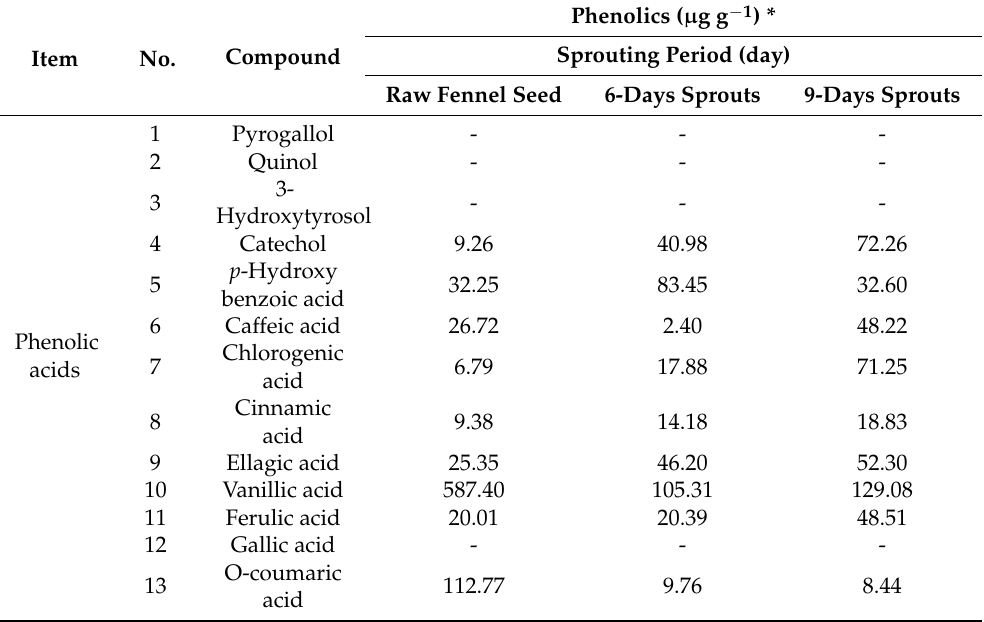
Figure 1. Total phenolic content ( A ), total flavonoids ( B ), total flavonols ( C ), and potential antioxidant activity ( D ) of FS after 15 days of sprouting at 17 ± 1 °C and 90–93% RH (mean ± SE), n = 6. a,b,c,d : There is a statistically significant ( p > 0.05) difference between bars that do not share identical lettering. Table 1. Quantitative analysis of phenolic compounds in FS, 6th day sprouts, and 9th day sprouts during sprouting at 17 ± 1 ◦ C and 90–93%